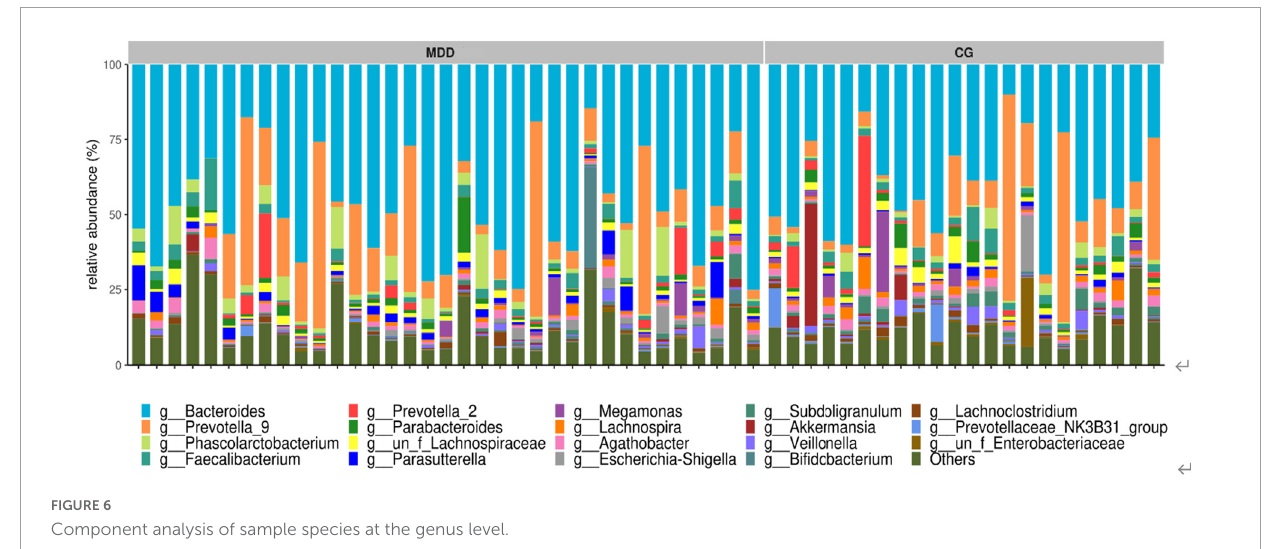
FIGURE6 Component analysis of sample species at the genus level.